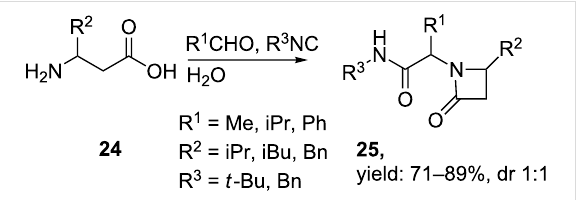
Scheme 9: General MCR for β -lactams in